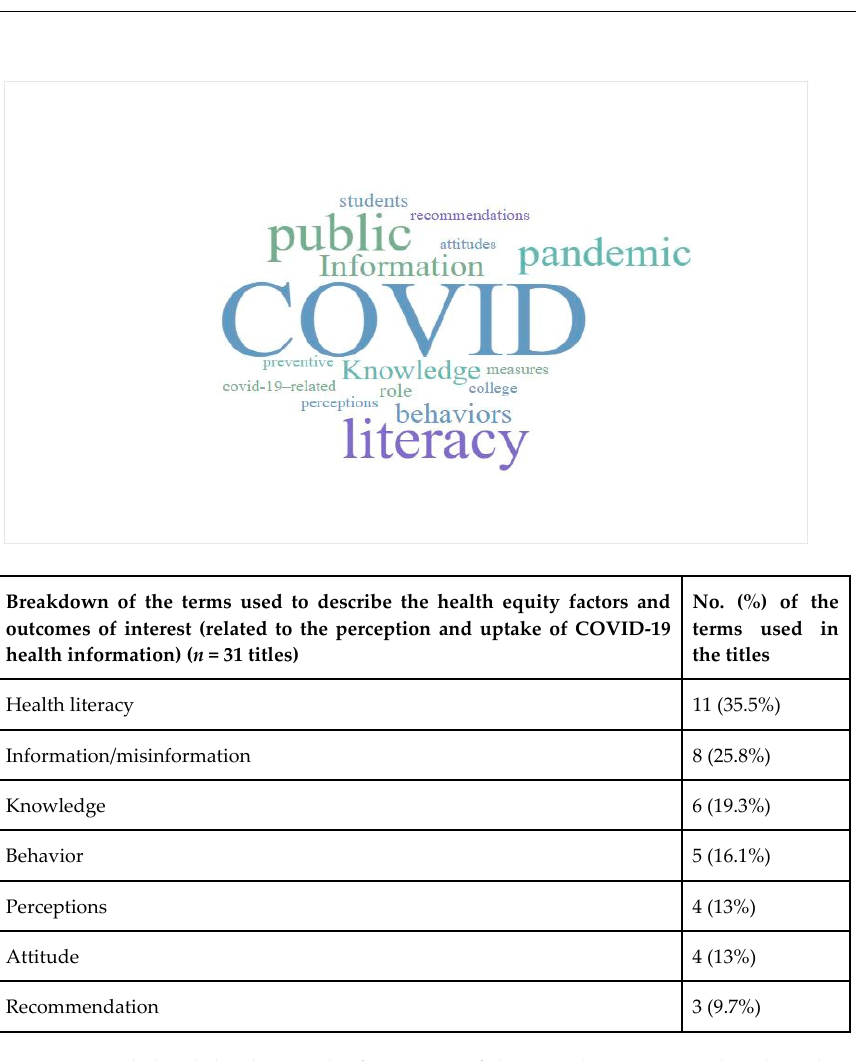
Figure 2. Word cloud displaying the frequency of the popular terms used in the titles of extracted papers. The font size of the word corresponds to its frequency of use in the included studies’ titles. The larger the terms, the higher the frequency. The frequency of the terms displayed on the word cloud are shown in the above table.